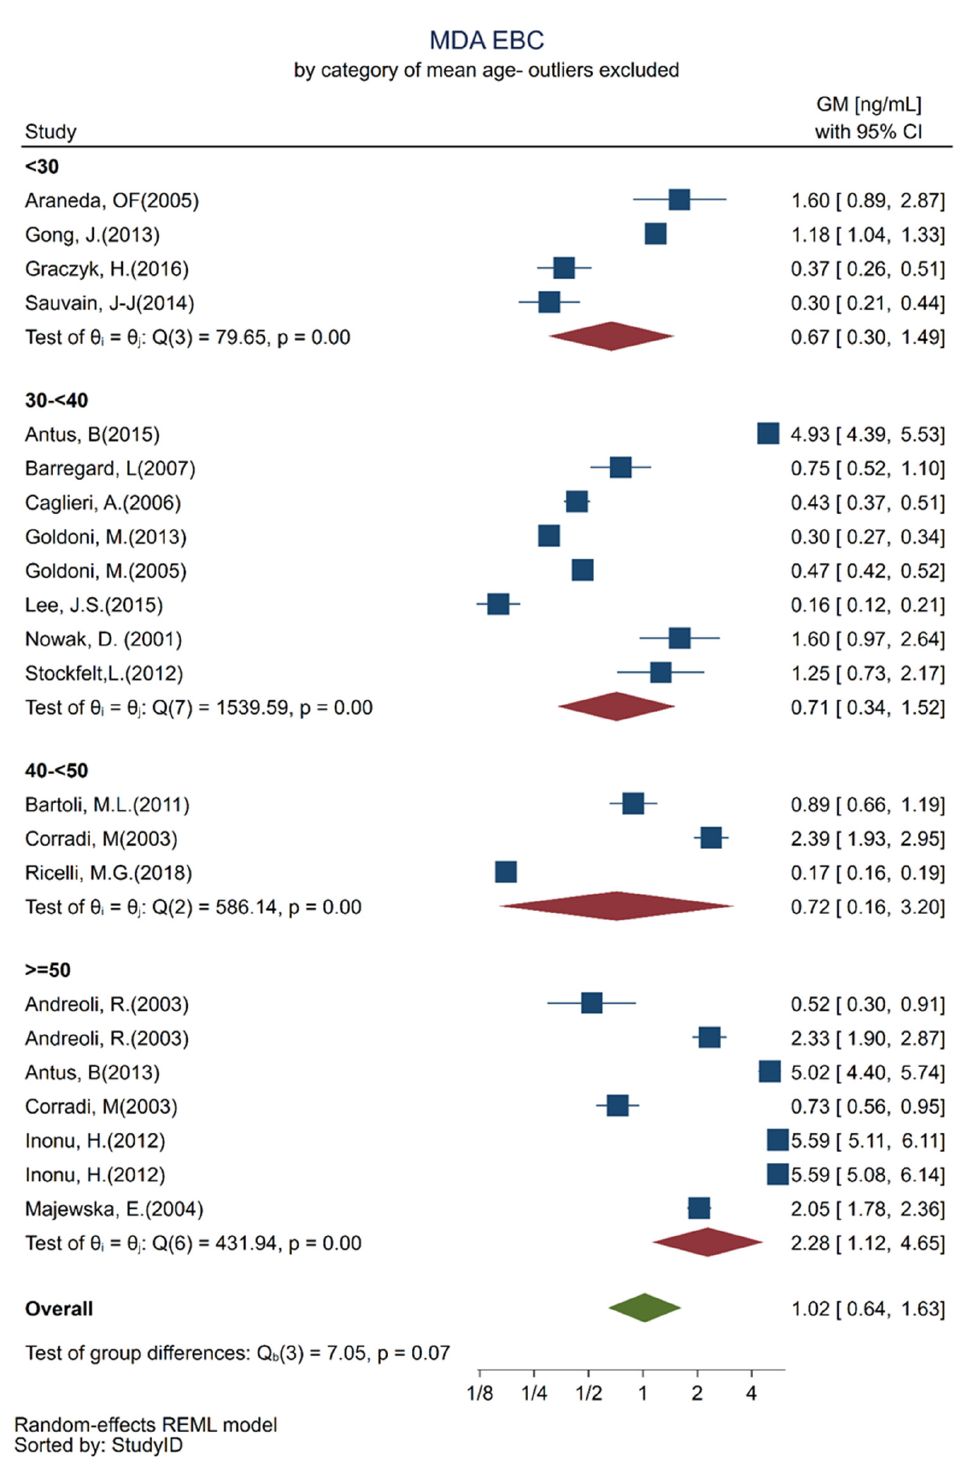
Figure 3. Forest plots of MDA in EBC concentration quantified in healthy adult participants by age group: population with a mean age less than 30 years [28,43,46,58]; between 30 and 40 years [25,31,34,41,42,49,51,59], between 40 and 50 years [32,36,55] and above 50 years [24,26,36,46,50]. The predicted GMs in ng/mL for MDA measured in EBC is provided in Table 3, as well as the 95% confidence interval for each parameter considered. We observe that most of our predicted values fall in the interval of 0.18–2.87